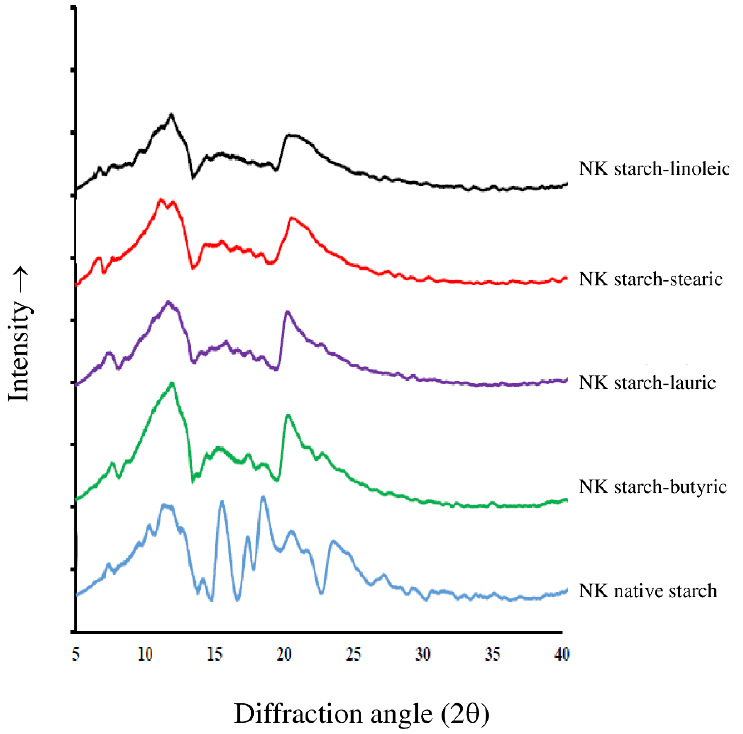
Figure 3. X-ray diffraction (XRD) pattern of native Noui Khuea (NK) starch and NK starch – lipid complexes with different fatty acid chain length.